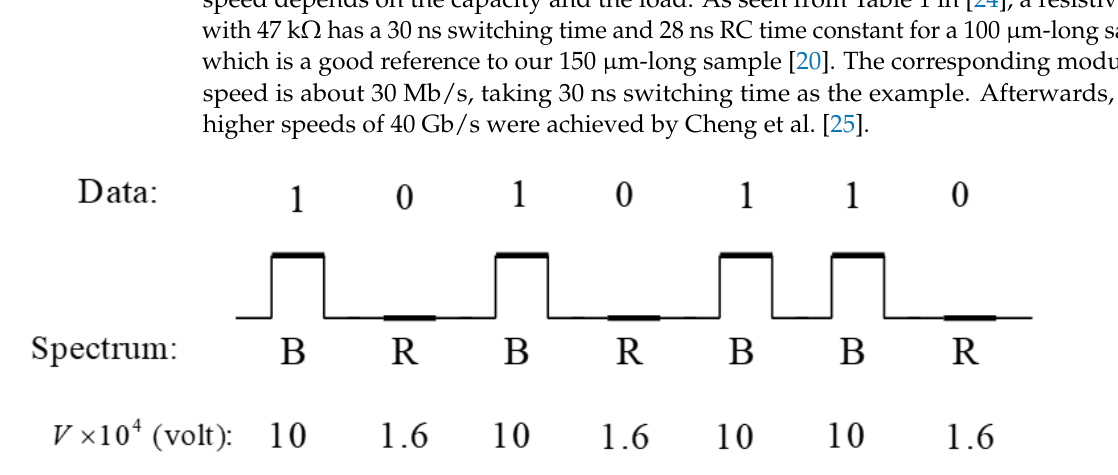
Figure 8. Illustration for the data encoding and transmission by controlling the magnitude of the applied field. The two-level data 0 and 1 are related to the spectral shifts R and B, respectively, which can be obtained by varying the magnitude of the applied voltage V .